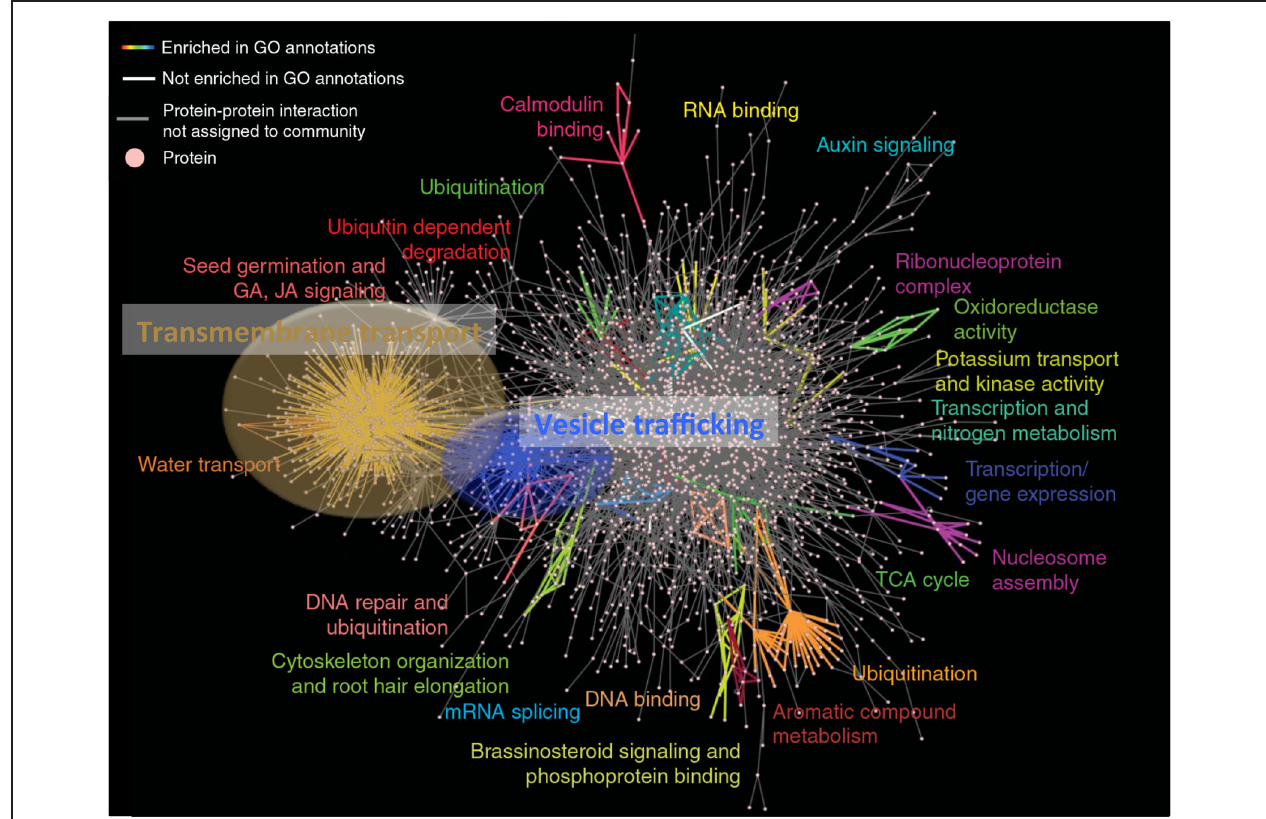
FIGURE 1 | The large transmembrane transport community (brown) shares a high amount of proteins with the vesicle trafficking community (blue) suggesting a strong physical and functional overlap and interaction. AI-1 MAIN communities enriched in gene ontology annotations are colored. Modified from Arabidopsis Interactome Mapping Consortium